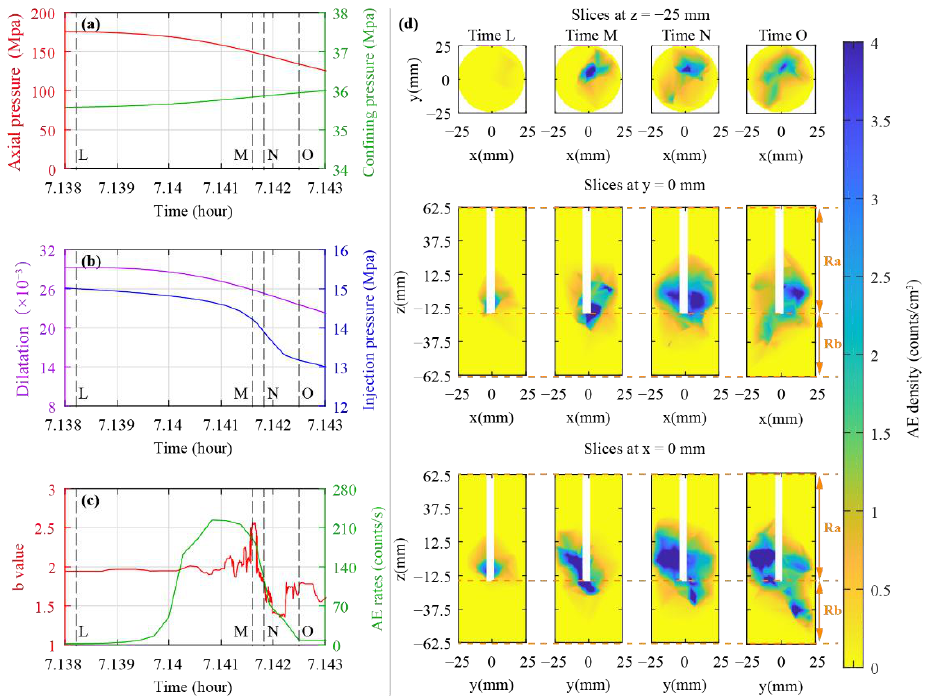
Figure 12. Mechanical response and acoustic emission density images of rock in H2 phase: ( a ) axial (red line) and confining pressure (green line); ( b ) dilation (purple line) and water injection pressure (blue line); ( c ) b-value (red line) and AE rate (green line); ( d ) slices of the 3D AE density images at different times (Times L~O correspond to the time points marked by black dotted lines in the left subfigures). The orange dotted line in subfigures ( d ) represents the boundary between region Ra and Rb.